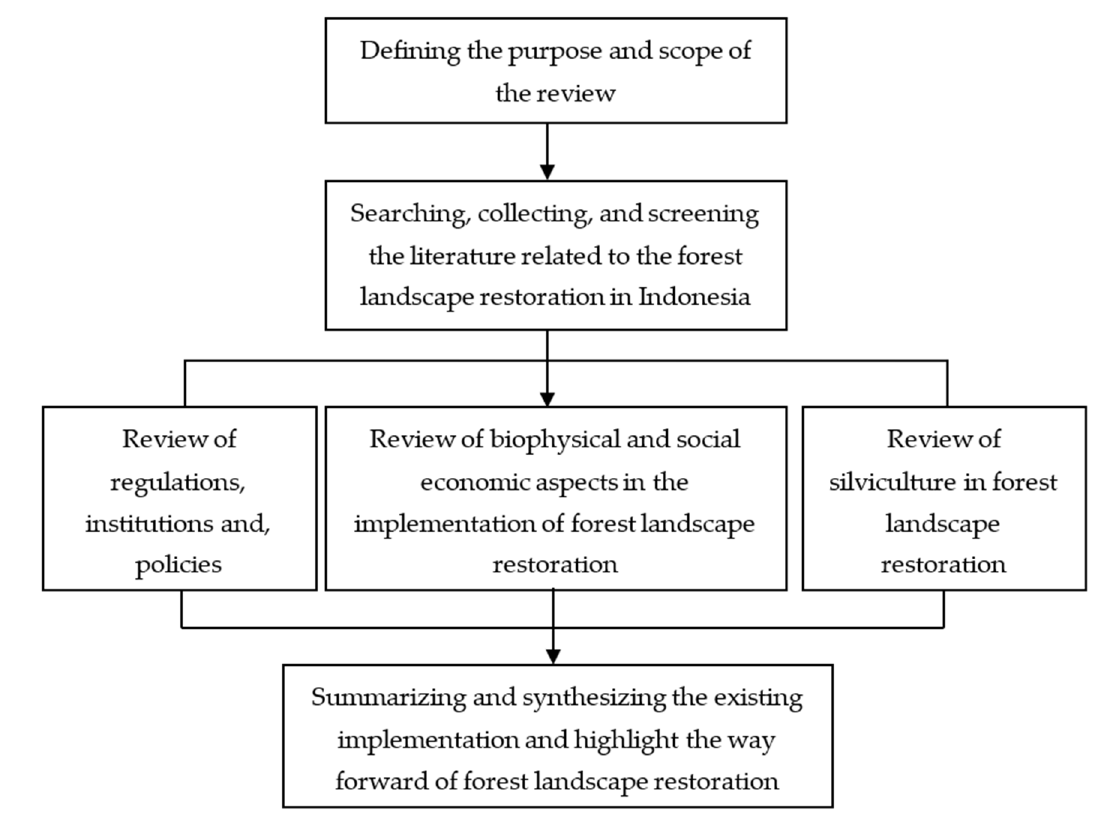
Figure 1. Stages in conducting the review.